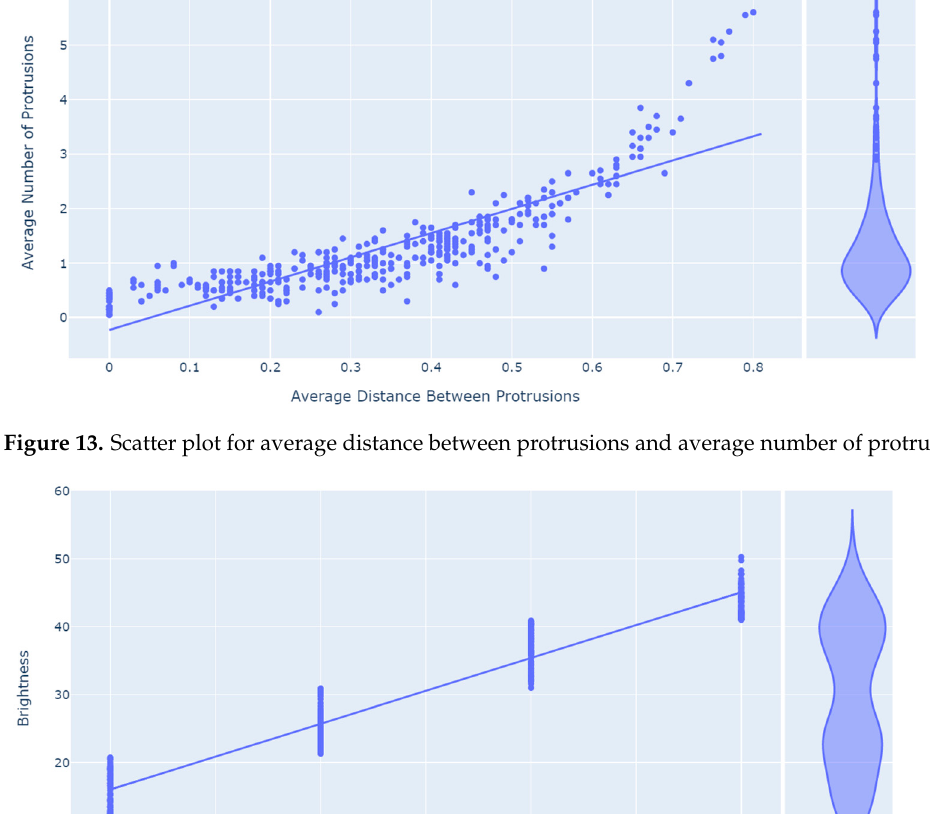
Figure 12. Scatter plot for max height and average height of protrusions.